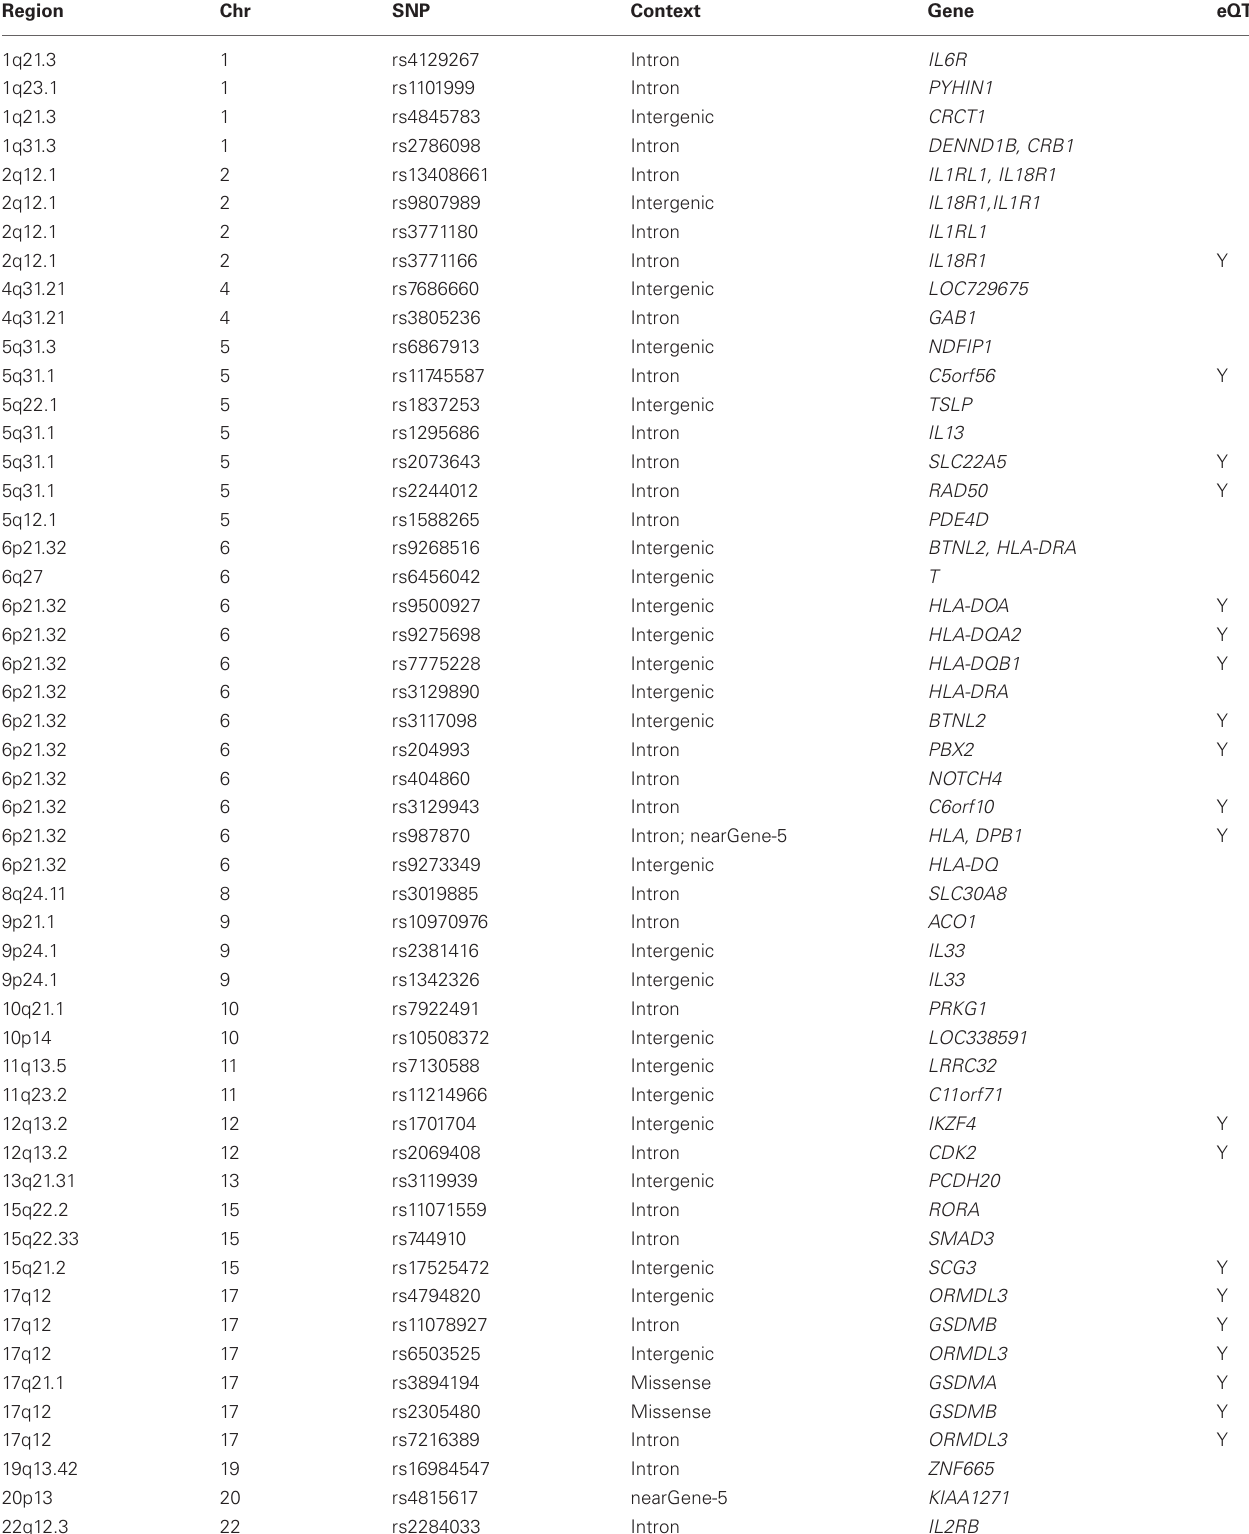
Table A1 | Published asthma associated SNPs in the GWAS catalog as of January 15, 2013.